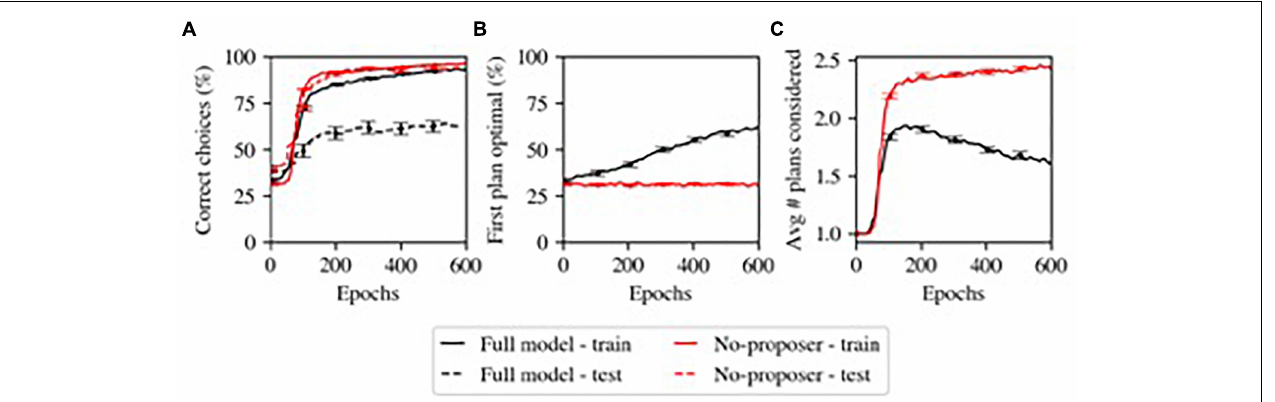
FIGURE 3 | Model’s simulation of habitization (from Herd et al., 2019). Performance grows faster with more training, but generalization is sacrificed. (A) Performance (% correct). The model with the Proposer component (Full model) performs worse at generalization (test – dashed lines). (B) The Proposer component learns correct behavior over time, with increasing probability of producing optimal plans for first consideration. (C) The Proposer’s learning reduces the total number of plans considered, by providing good options for first consideration, and thus also reduces total performance time. This may capture one factor in habitization in humans and